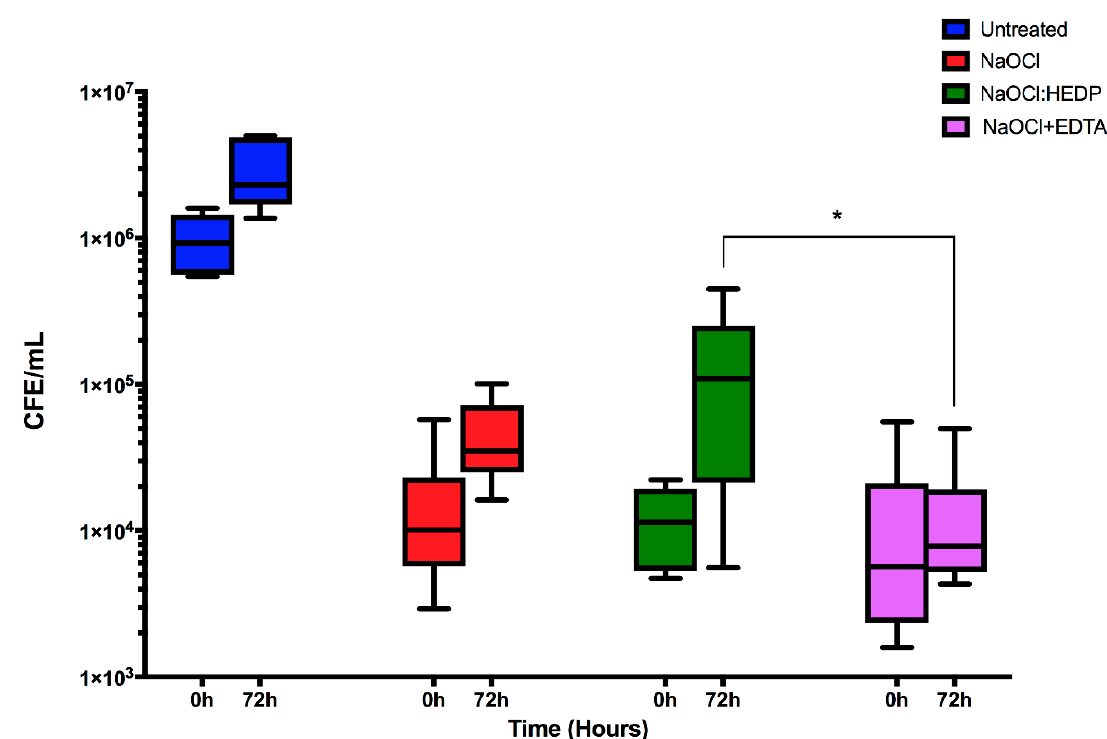
Figure 3. The e ff ect of the three endodontic irrigants on C. albicans in pre-formed 24 h dual-species biofilm. NaOCl alone, NaOCl:HEDP and NaOCl + EDTA were used to treat mixed species biofilms and C. albicans quantified. Box and whisker plot of CFE at 0 h and 72 h for each treatment. Values were plotted as log 10 on the Y axis. Statistical significance between the three treatment conditions at 72 h was presented as * p < 0.05. Results represent data from three independent experiments.